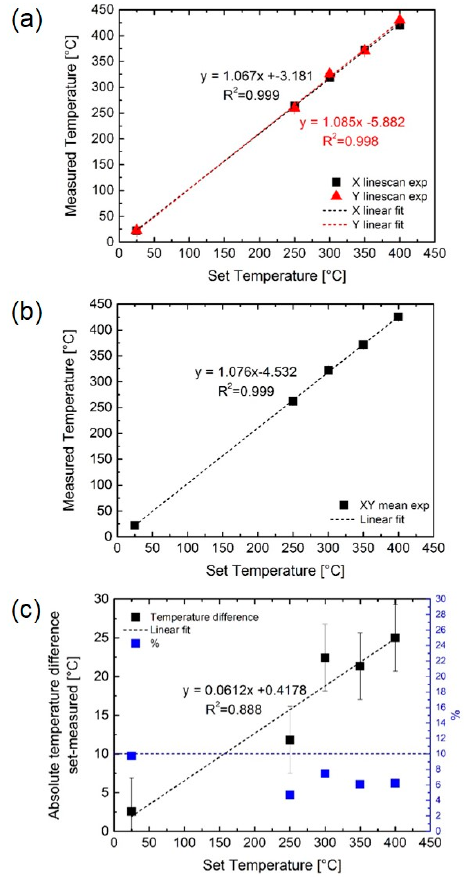
Figure 6. ( a , b ) Difference between the set and measured temperatures on the Si- µ hp: X-Y line scans and the average between the line scans, respectively. ( c ) Absolute temperature difference between set and measured temperatures, including the error percentage (blue symbols—right y-axis). The dashed horizontal blue line symbolizes the 10% error threshold. The error remains below this threshold at all measured temperatures.